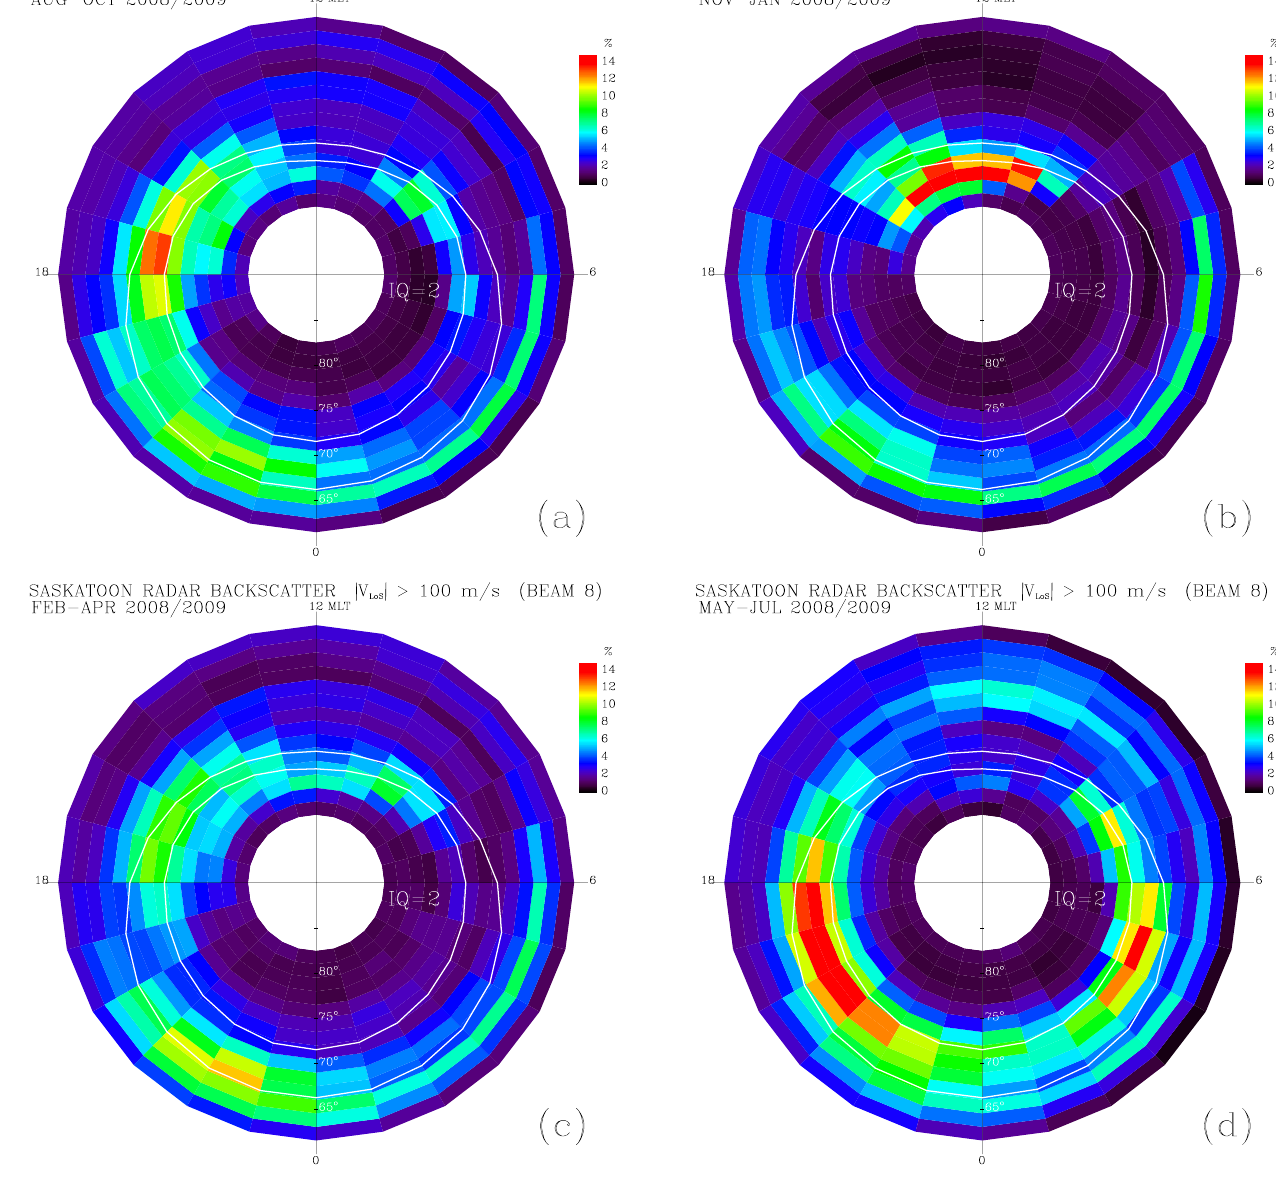
Fig. 10. The ionospheric backscatter occurrence observed with the Saskatoon radar beam 8 in (a) autumn, (b) winter, (c) spring and (d) summer. Superposed in white line is the Feldstein oval for